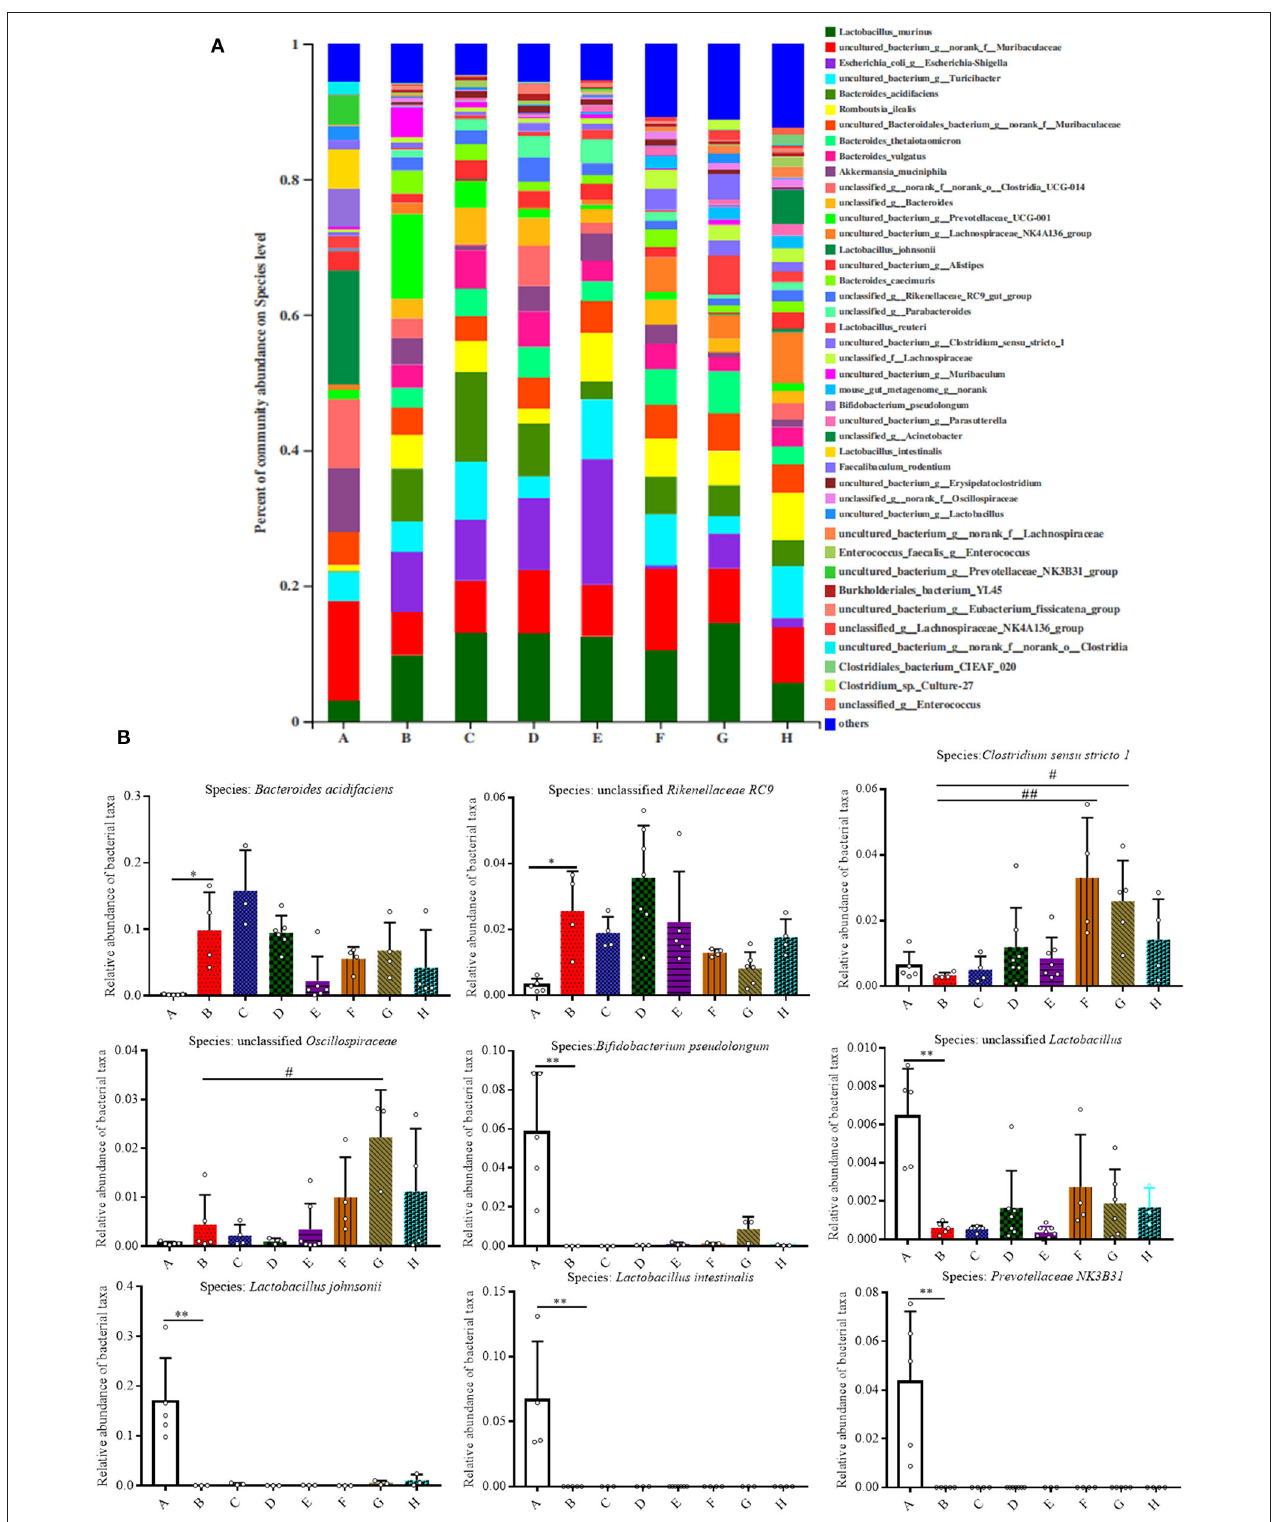
FIGURE 5 | Effect of SFN on gut microbiota compositions at the species level in colitis mice. (A) Gut microbiota compositions at the species level in each group. (B) Relative abundance of predominant bacterial community members at the species level. All data are presented as the mean ± SD. P -value < 0.05 was considered to indicate statistical significance (* P < 0.05 and ** P < 0.01 compared with Group A, # P < 0.05 and ## P < 0.01 compared with Group B).